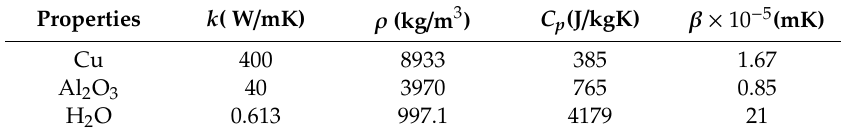
Table 1. Cu thermophysical properties along with Al 2 O 3 and H 2 O (Oztop and Abu Nada [60]). Properties